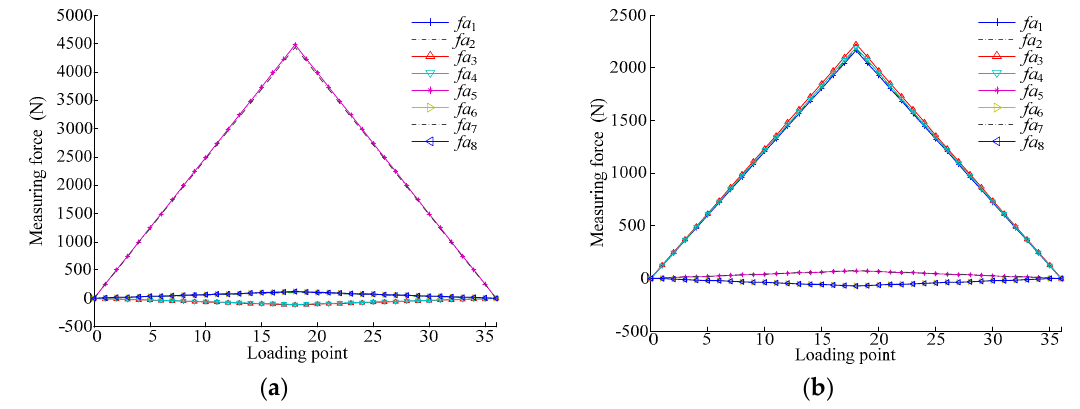
Figure 6. Output values of numerical model for load on the sensor under ( a ) F x and ( b ) F z . The minimum and maximum output values of the numerical model for the measurement modules in the X-direction, shown in Figure 6a, are provided in Table 4. Table 4. Output value of generalized force in the X-direction.